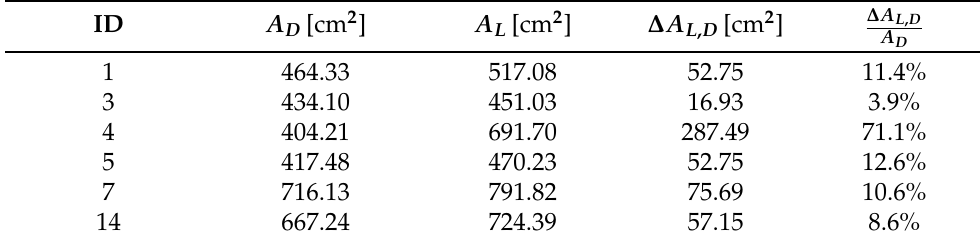
Table 3. Comparison of the results provided by the reference methods for data set p 1_ l . Leaf areas given by the digitizer A D and by the leaf area meter A L